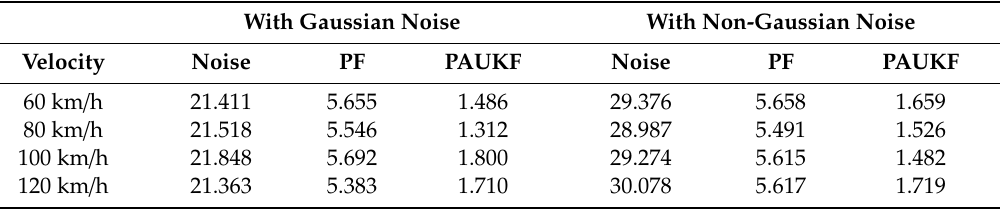
Table 5. RMSE of filters in different conditions (unit: m).